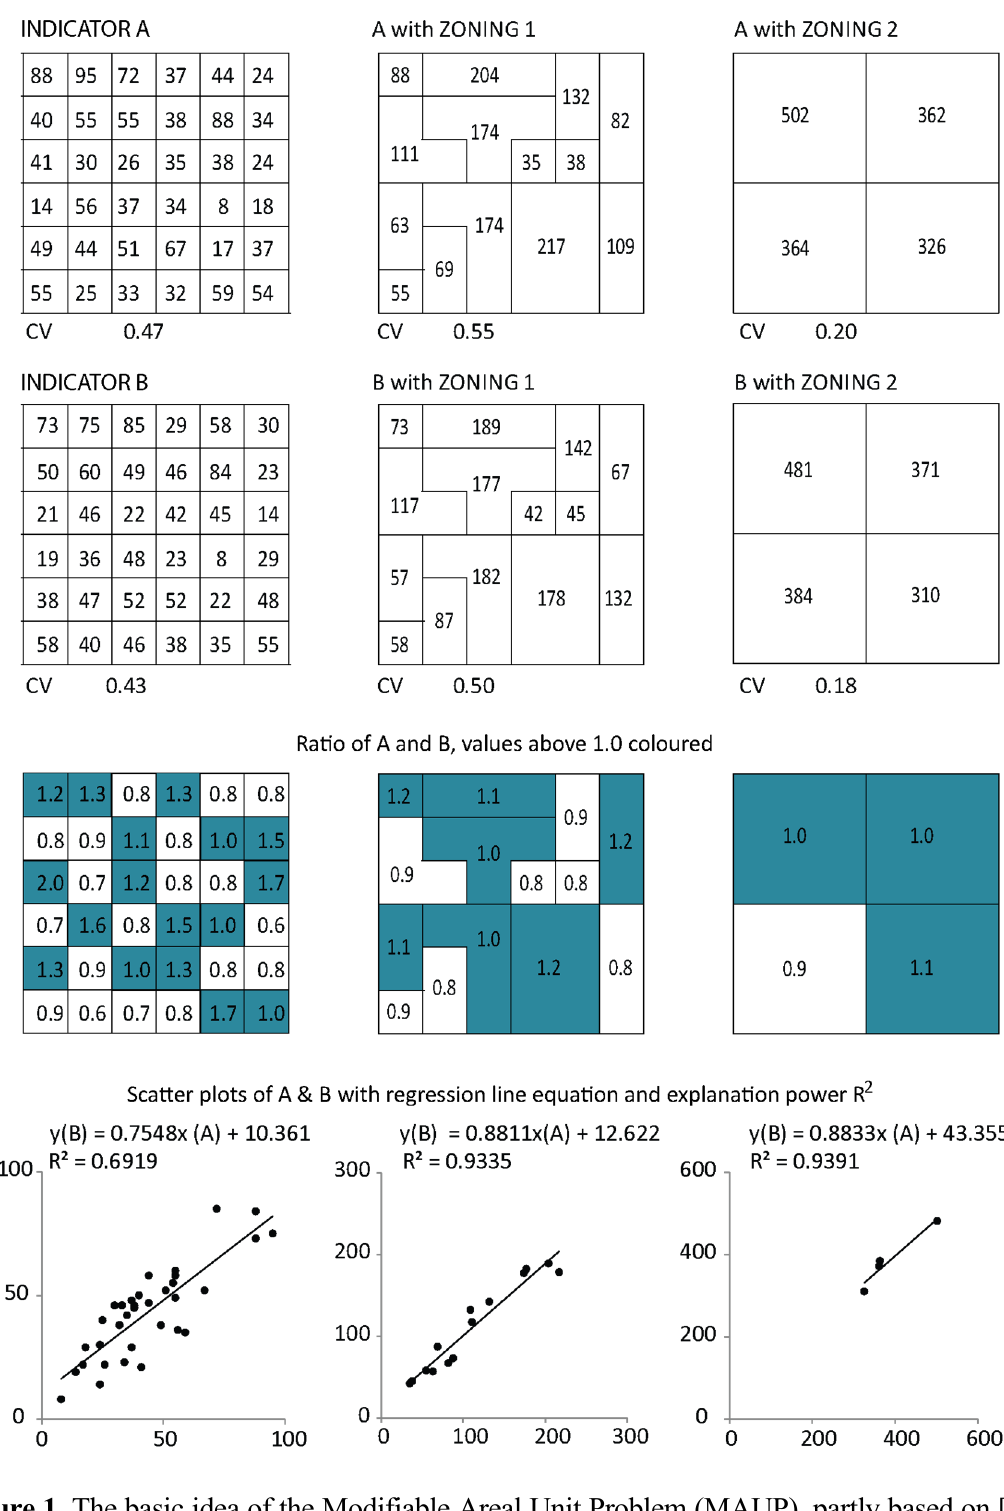
Figure 1. The basic idea of the Modifiable Areal Unit Problem (MAUP), partly based on [52]. A and B represent variables such as population and available water. In zoning 1, the units of analysis vary in size. In zoning 2, zones are created by regularly combining 9 grid